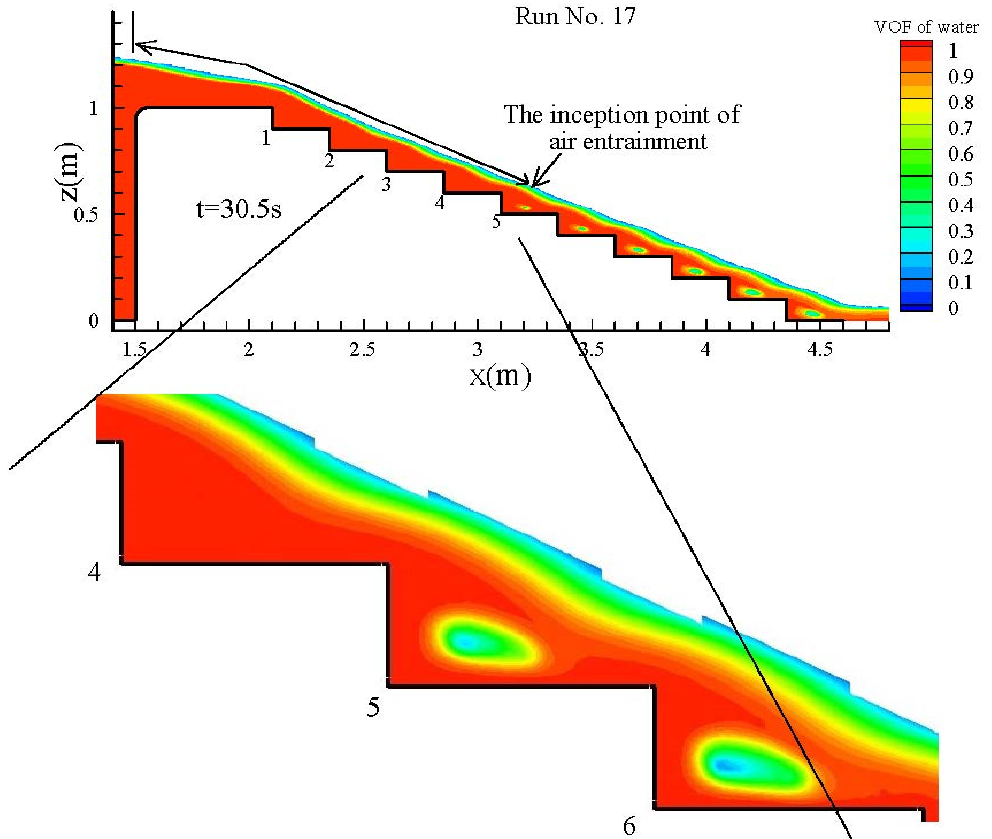
Figure 14. Numerical void fraction of water on different instant at Run No.